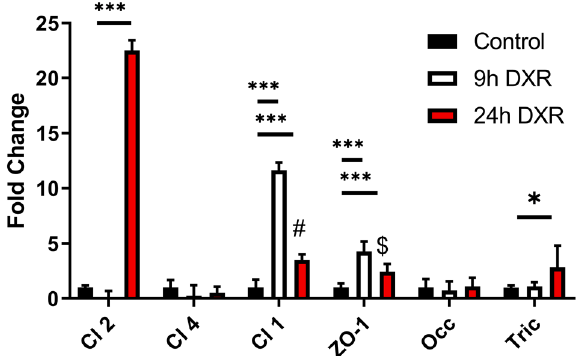
Figure 3. Doxorubicin exposure modulates tight junctional gene expression in a time dependent manner. RT-qPCR of T84 cell mRNA at 9 h and 24 h after DXR exposure with time respective controls. The experimental design is the same as Fig. 1A. All data is presented as fold change normalized to ACTB . n = 6 wells/ group. Statistics: 2 way ANOVA followed by Tukey’s HSD; ***p < 0.001.